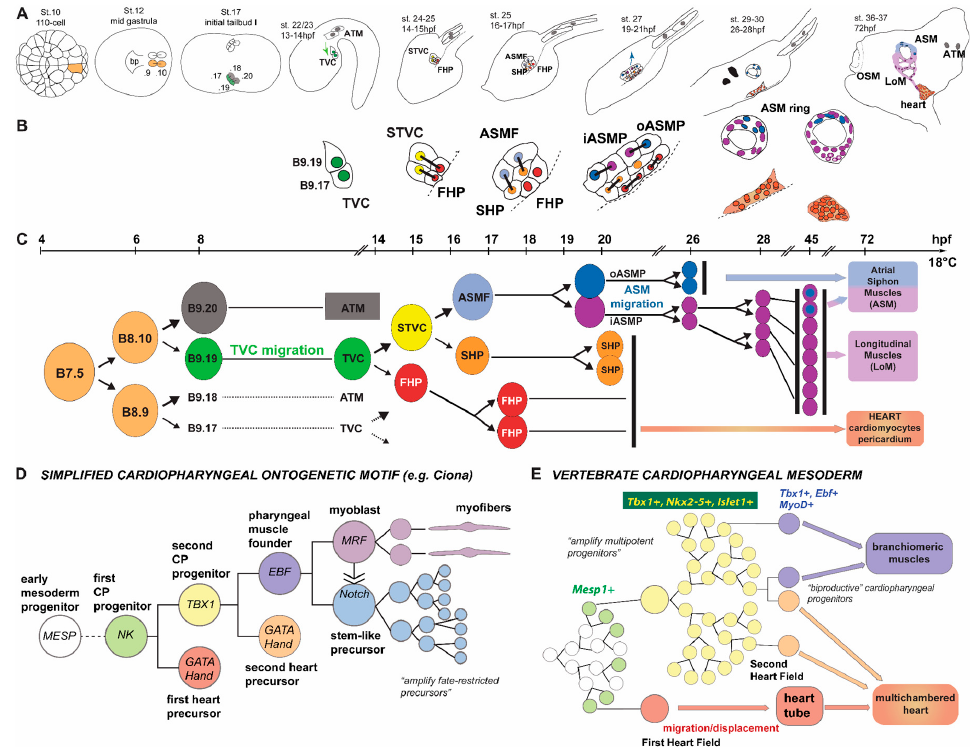
Figure 5. Summary of cardiac cell lineage specification in Ciona. ( A ) Schematic embryos, larvae, and juvenile showing the B7.5-derived cardiopharyngeal lineage, with approximate hours post-fertilization (hpf) and stages according to [59]. Numbers in the left second and third panels are simplified version of cell names according to Conklin (1905) nomenclature and corresponding the ( C ). Arrows indicate collective TVC ( green ) and ASMP ( blue ) migrations. TVC: trunk ventral cells; ATM: anterior tail muscles; STVC: second TVC; FHP: first heart precursor; SHP: second heart precursor; ASMF: atrial siphon muscle founder cells; iASMP: inner atrial siphon muscle precursor; oASMP: outer atrial siphon muscle precursor; LoM: longitudinal body wall muscles (note that they derive from the iASMPs); OSM: oral siphon muscles, derived from the A7.6 lineage [60]; bp: blastopore; and ( B ) close-up views of cardiopharyngeal lineage cells. Black bars link sister cells (as per the lineage shown in C). White asterisks in the ASM ring at ~72 hours post fertilization indicate iASMP-derived LoM precursors that reactivate Mrf and the body wall muscle differentiation program [31]. Note that the relative contributions of the FHP and SHP to the different parts of the differentiated heart (epicardium, myoepithelium, raphe, and pacemakers) remain elusive; ( C ) Lineage representation of cadiopharyngeal mesoderm development. Color codes correspond to those used in A and B. Only the progeny of one TVC for one side of the animal is shown, but this pattern is reiterated 4 times in each developing embryo, such that the Ciona equivalent of the first and second heart fields (see B) are composed of distantly-related FHP and SHP. For example, the left second heart field is composed of the anterior/leader and posterior/trailer SHPs, whose last common ancestor is the Mesp + left B7.5 blastomere; ( D ) simplified cardiopharyngeal ontogenetic motif as seen in Ciona, illustrating that in ascidian embryos, cell fates are first restricted to a few progenitors, which are secondarily amplified (as seen for both the ASMP, and heart precursors); and ( E ) schematic representation of equivalent cardiopharyngeal ontogeny in vertebrates, where multipotent progenitors from larger populations in the early embryos, these morphogenetic fields are patterned by cell-cell signaling causing spatially-defined progressive fate restrictions such that not every single multipotent progenitor expresses its full potential. This may explain why a small fraction (~10%) of the bipotent cardiopharyngeal progenitors produce both skeletal head muscles and SFH-derived cardiomyocytes, whereas these populations are easily switched to one fate or another experimentally. The existence of such plastic populations of multipotent progenitors probably fostered the diversification of cardiopharyngeal structures in